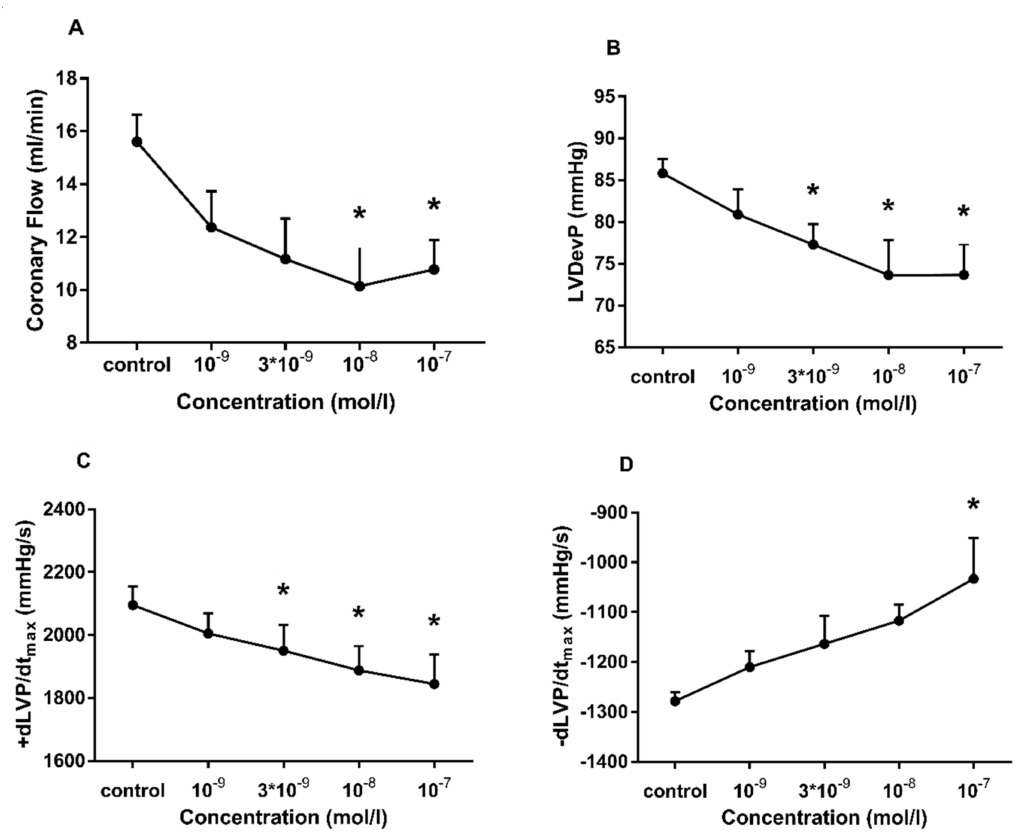
Figure 2. Concentration-dependent effects of angiotensin II (Ang II) on coronary flow ( A ), left ventricular developed pressure (LVDevP) ( B ), +dLVP/dt max ( C ) and − dLVP/dt max ( D ) of isolated rat hearts. In these experiments, Ang II was applied in the range of 10 − 9 to 10 − 7 M. The increasing concentrations of Ang II were infused into the perfusion line consecutively, each for 3 min. Maximal effects measured during the 3-min infusion periods are presented. Mean ± SEM; n = 4; * p < 0.05 vs. control (pre-infusion value); one-way repeated measurement ANOVA or ANOVA on ranks and Dunnett’s post-hoc